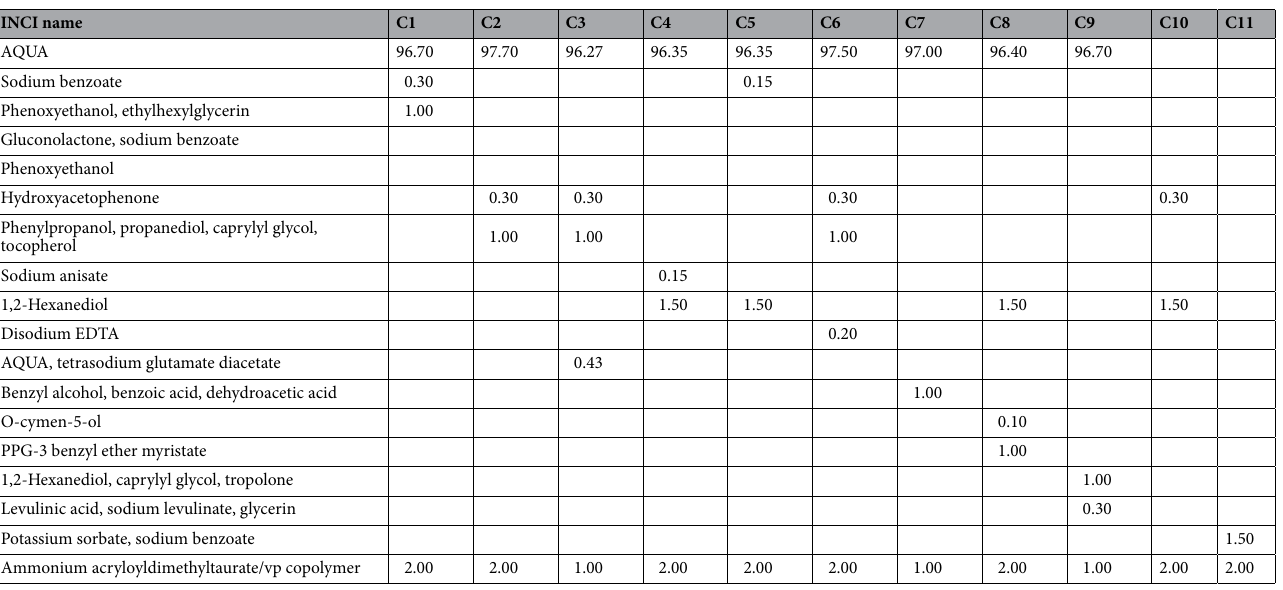
Table 1. List of formulations [C1-C12] containing preservatives used in this